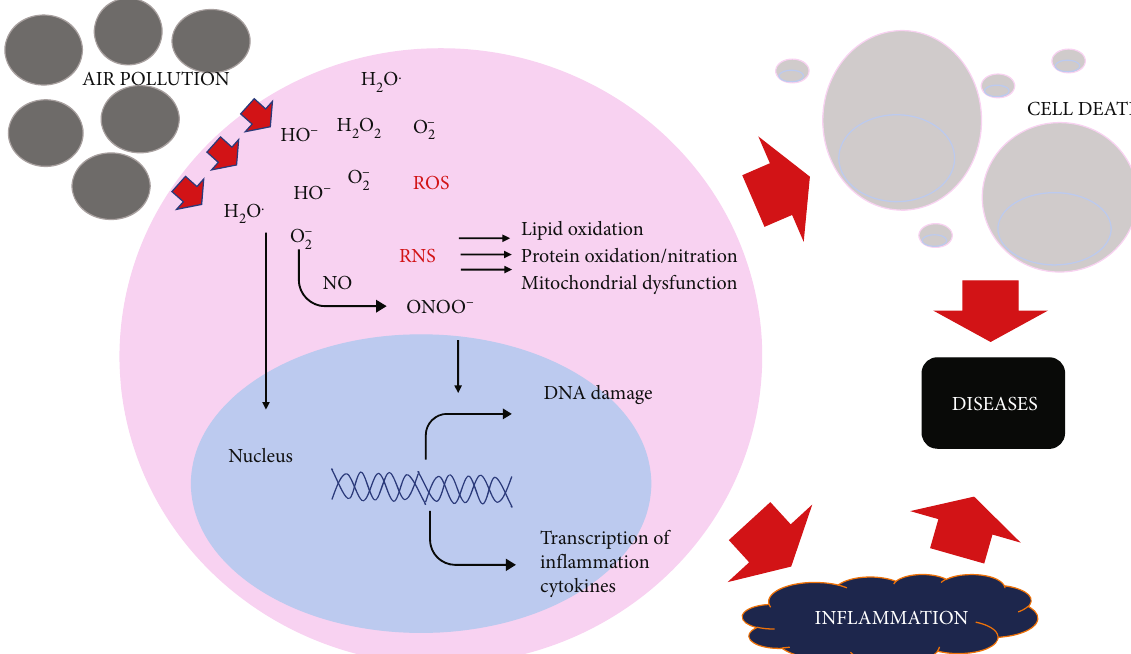
Figure 3: Correlation between air pollution, oxidative stress, and diseases. ROS, reactive oxygen species; RNP, reactive nitrogen species; ONOO − , peroxynitrite; HO − , hydroxyl ion; NO, nitric oxide; O